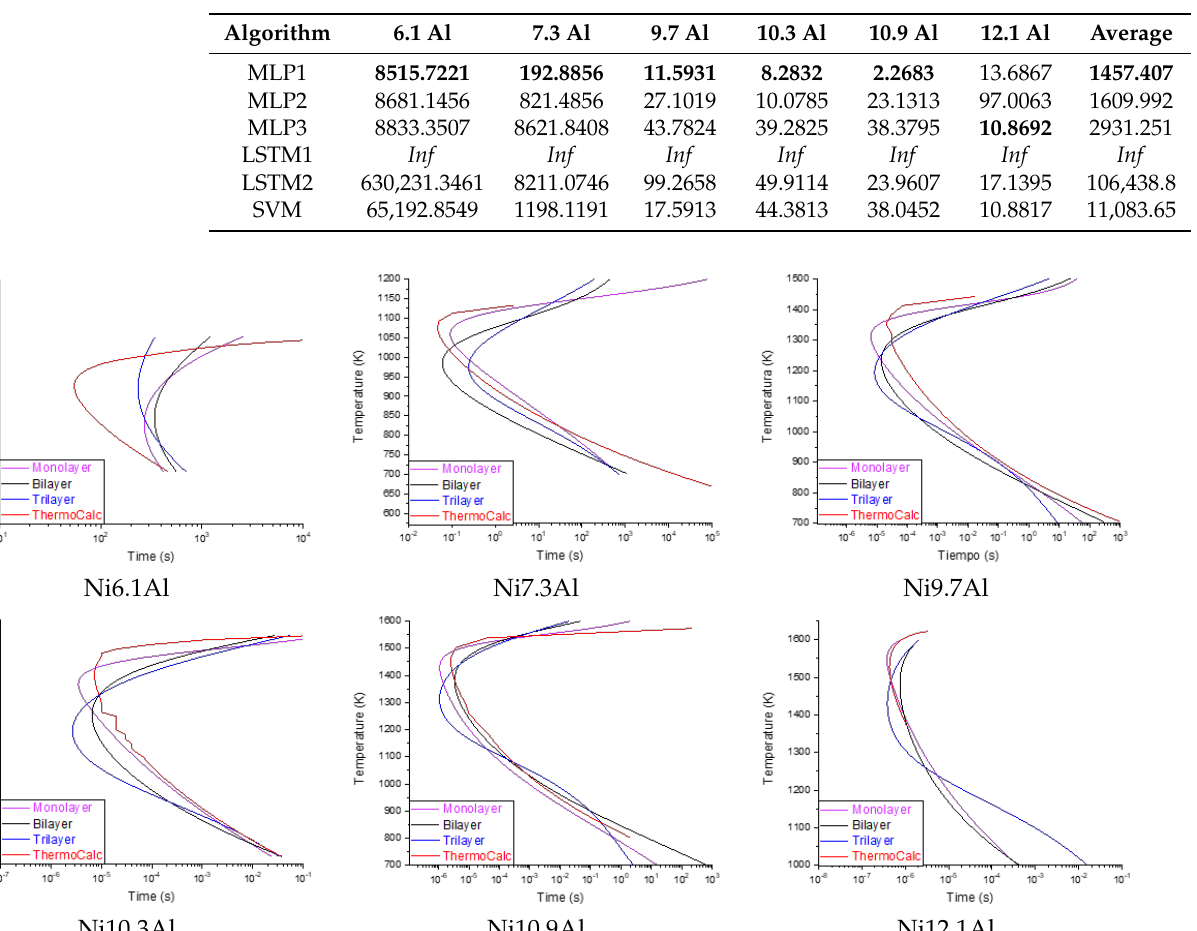
Table 5. Comparison of the different RMSE (in seconds) calculated for the different algorithms evaluated in Exp. 4. Figure 4 shows the predicted TTT curves.